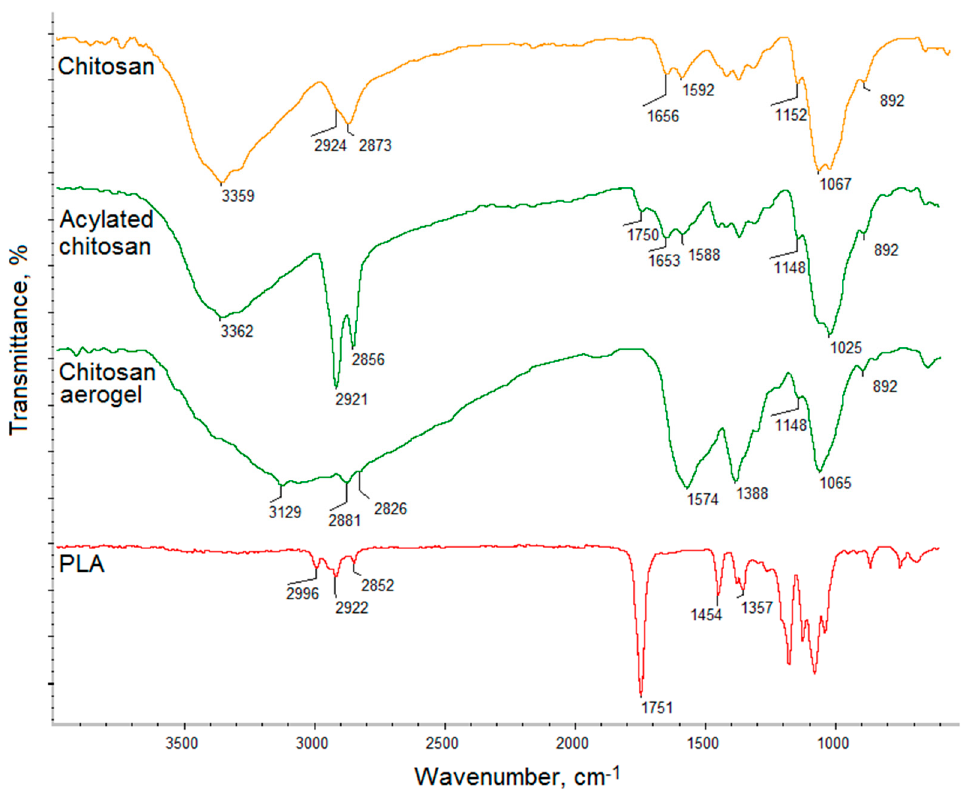
Figure 1. FT-IR spectra of the raw chitosan, acylated chitosan, chitosan aerogel, and